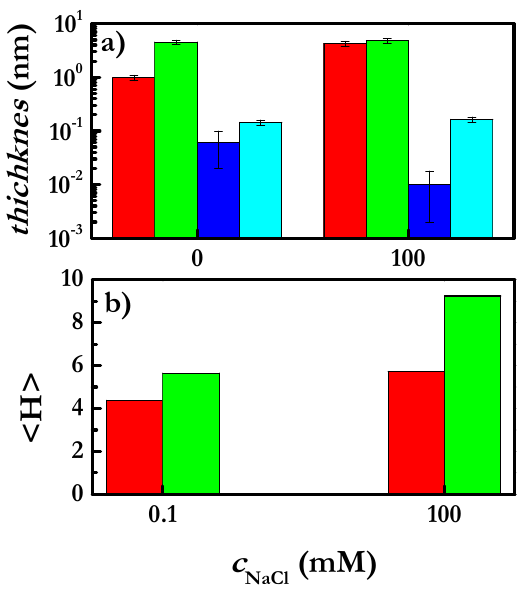
Figure 7. ( a ) Effect of ionic strength on the hydrodynamic and optical thicknesses of CHI and CHI-SLES layers obtained via the deposition of layers from solutions with a polymer concentration of 2 g/L. The concentration of SLES in the mixed solutions was constant, at 0.1 mM. Each set of colored bars correspond to a specific set of data: h ac for CHI ( ■ ) and CHI-SLES ( ■ ) layers, and h op for CHI ( ■ ) and CHI+SLES ( ■ ) layers. Note that the reported thicknesses in the three panels correspond to those obtained after the rinsing of the adsorbed layers with aqueous solutions with the same NaCl concentration as that contained in the solutions used for the layer deposition. ( b ) Average thickness for CHI ( ■ ) and CHI-SLES ( ■ ) layers at different salt concentrations obtained from SCF calculations.